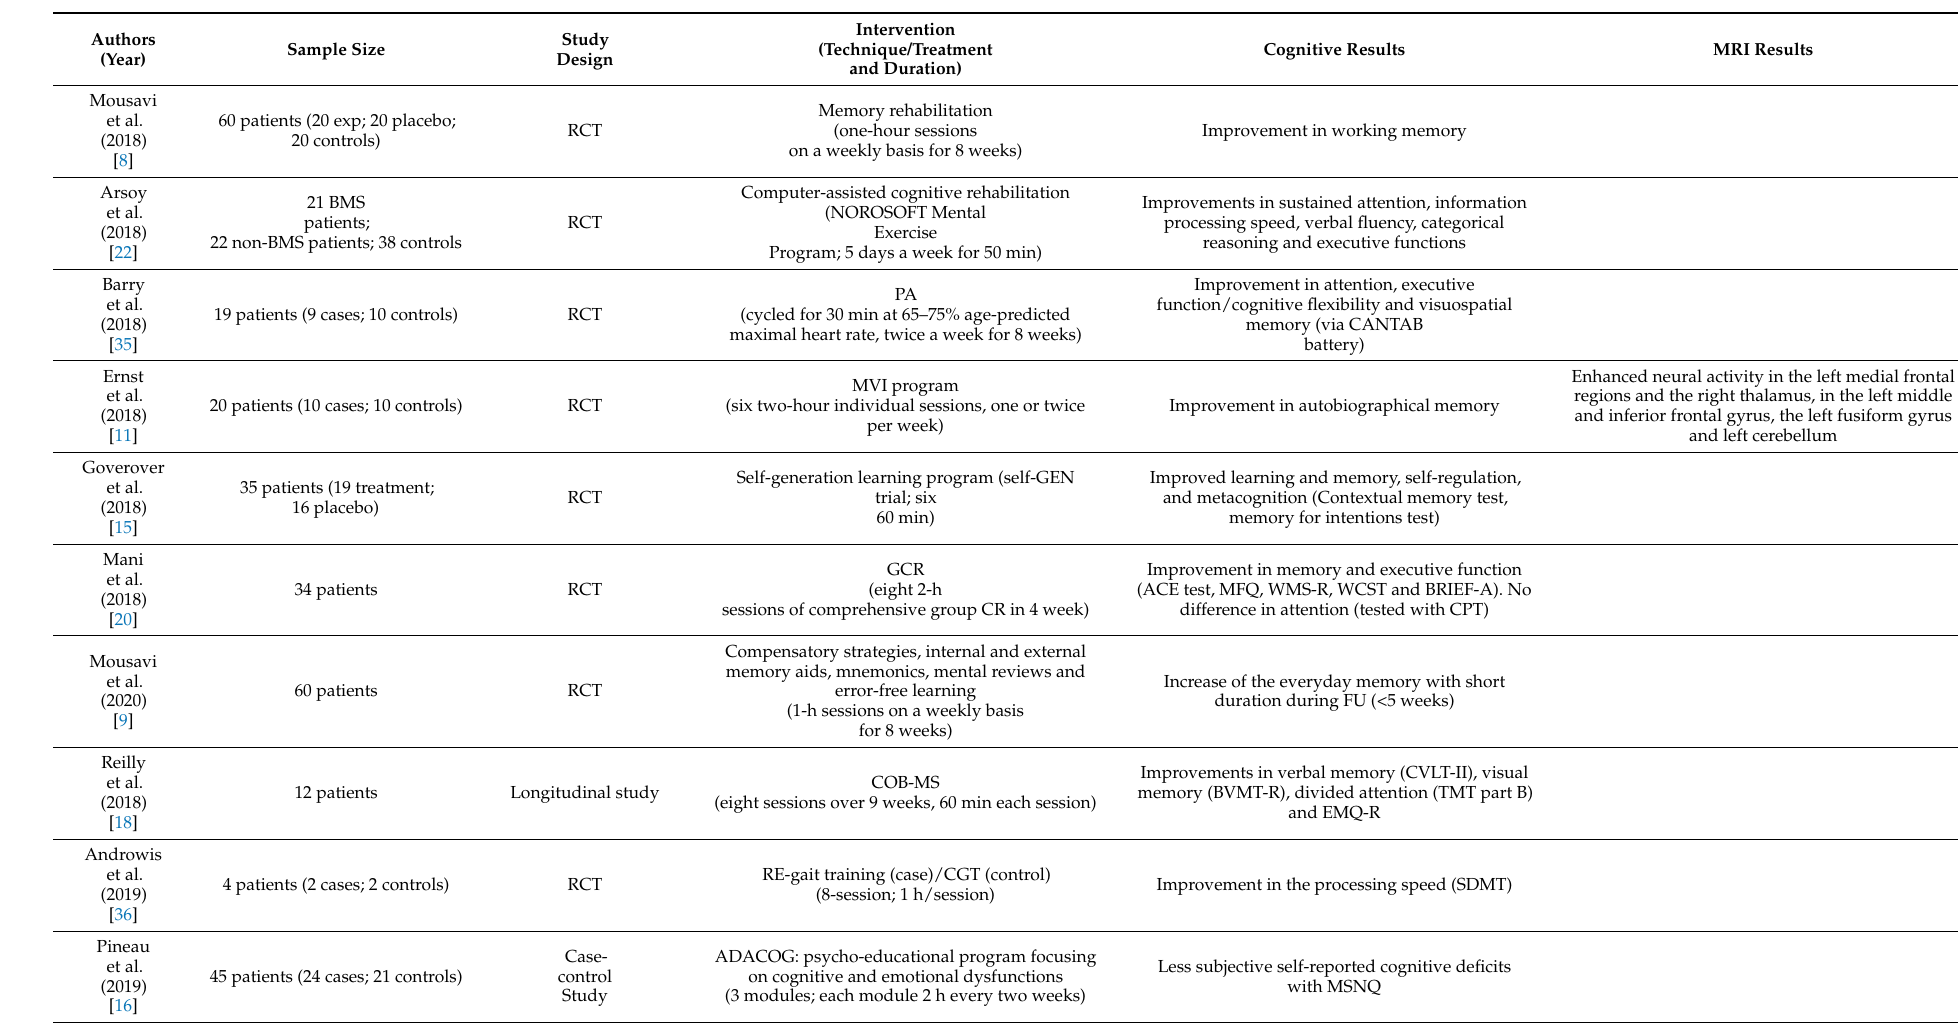
Table 2. In-presence cognitive and motor rehabilitative